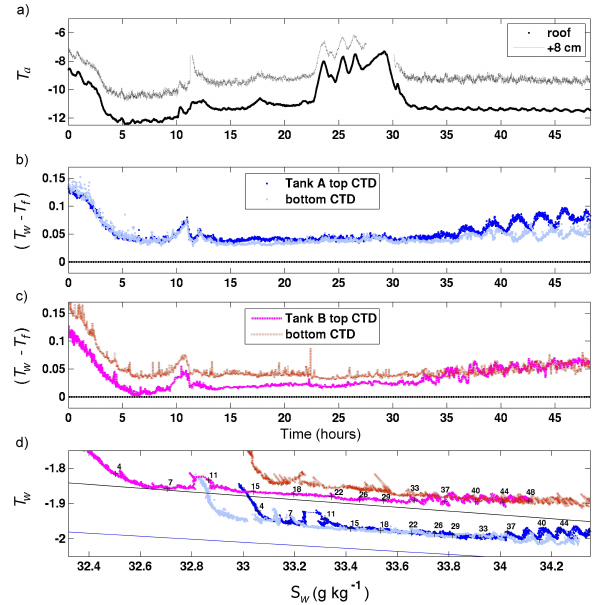
Fig. 2. Air temperatures and CTD data for E1: (a) T a from +8cm thermometer sensor in quiet tank and roof sensor, (b) and (c) devia- tion from freezing temperature for both CTD sensors in tanks A and B, respectively, (d) water temperature against salinity for both sen- sors and tanks. Tank B temperatures (red and pink) were displaced by +0.1 to avoid overlap with tank A data. Solid lines in (d) are the water freezing temperature (black line is displaced +0.1, to be comparable with tank B curves), while labeled numbers represent time (in hours) for top CTD data in each tank. All temperatures are given in ◦ C. X-axis for (a) , (b) and (c) represents time. Legends in (b) and (c) also apply to (d)